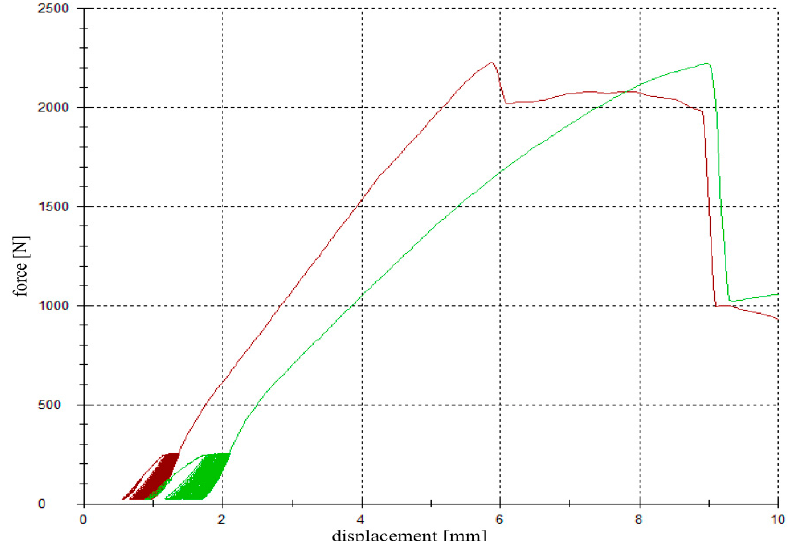
Figure 4. Load-displacement curve. A cyclic loading phase with 10 settling and 3000 measuring cycles was followed by a load-to-failure test. The red graph demonstrates the load-displacement curve of a specimen filled up with magnesium phosphate cement (MPC) (group 2), whereas the green graph corresponds to a specimen filled up with calcium phosphate cement (CPC) (group 3). Compressive strength and maximum pullout force (Section 2.3), as well as the displacement and maximum load in the fracture model biomechanical test set-up (Section 2.4), were recorded by a 20